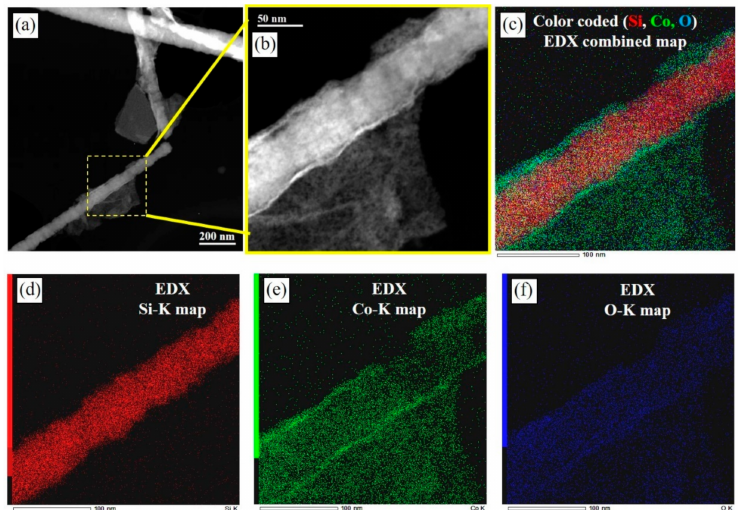
Figure 4. Selected TEM image of ( a ) the Co 3 O 4 -decorated SiC NWs with ( b ) Co 3 O 4 nano-flower- clusters; the corresponding mapping image of ( b ) is shown in ( c ), and the individual elemental Si (red), Co (green), and O (blue) mapping images are shown in ( d – f ),